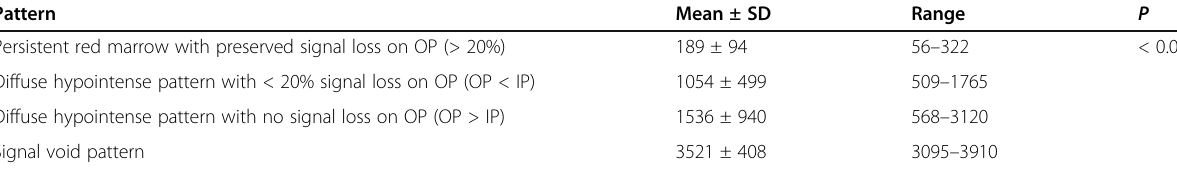
Table 2 Serum ferritin level across different patterns of diffuse marrow changes Pattern Mean ± SD Range P Persistent red marrow with preserved signal loss on OP (> 20%) 189 ± 94 56 – 322 < 0.001 Diffuse hypointense pattern with < 20% signal loss on OP (OP < IP) Diffuse hypointense pattern with no signal loss on OP (OP >